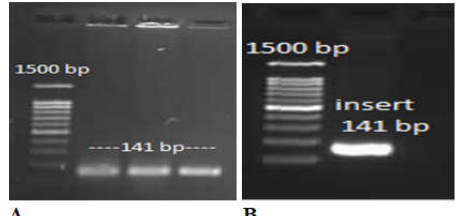
Fig. 1. Gel electrophoresis (Agarose 2%): A) Confirmation of vector entrance into competent cells